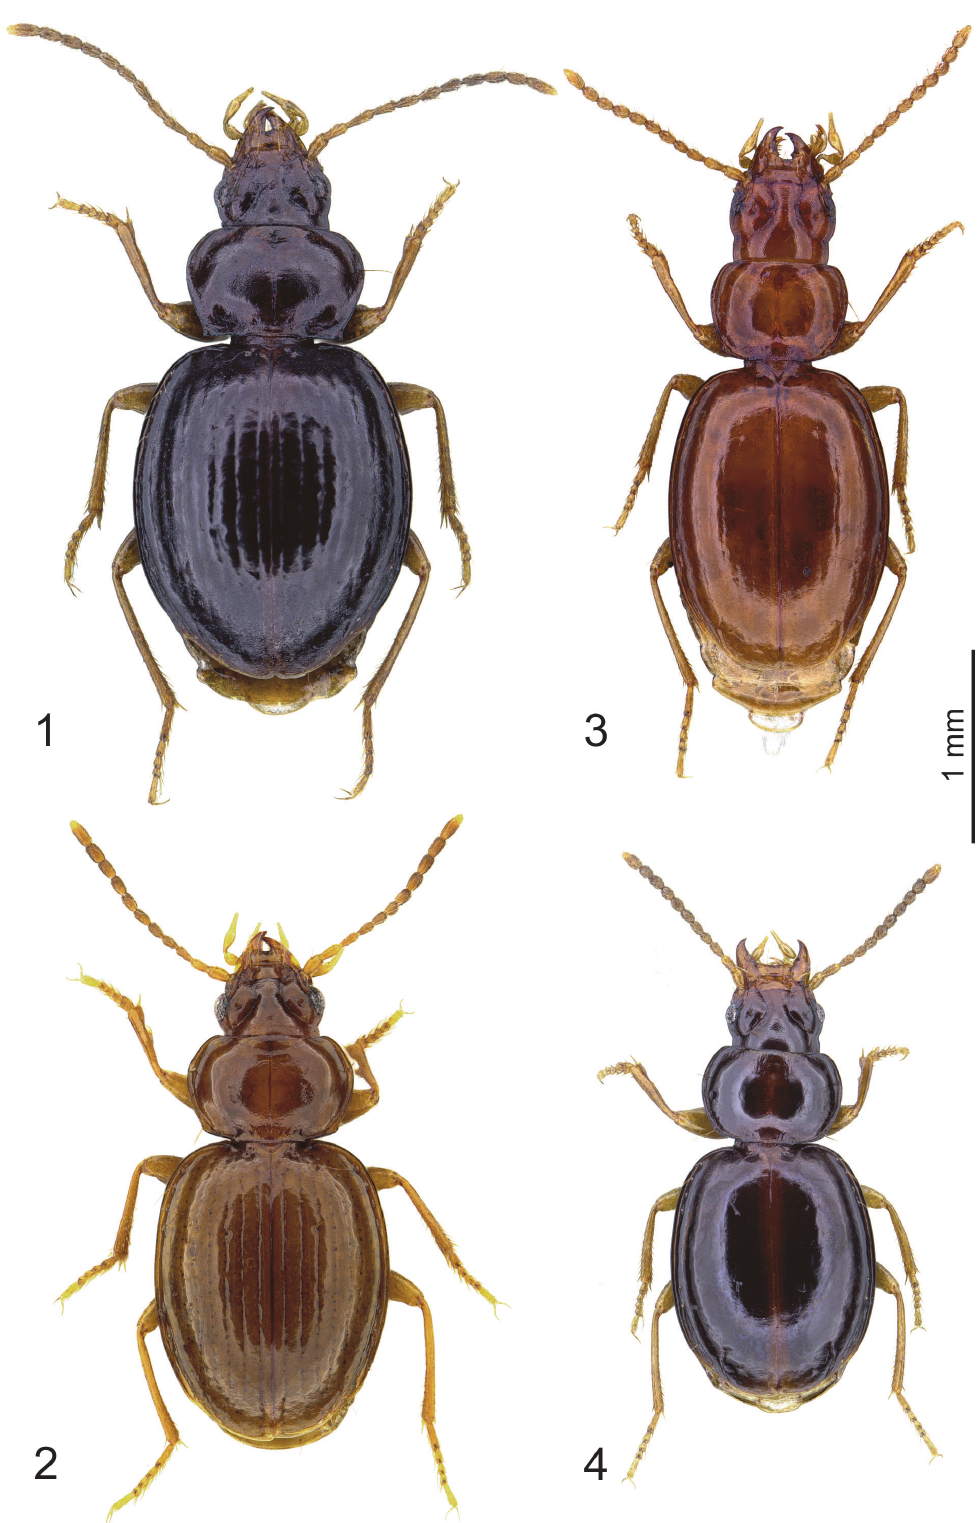
Figs 1–4. Trechus spp., habitus. 1 . T. mattisi sp. nov., paratype, ♂. 2 . T. transversicollis sp. nov., holotype. 3 . T. minitrechus sp. nov., paratype, ♂. 4 . T. nanulus sp. nov., paratype,